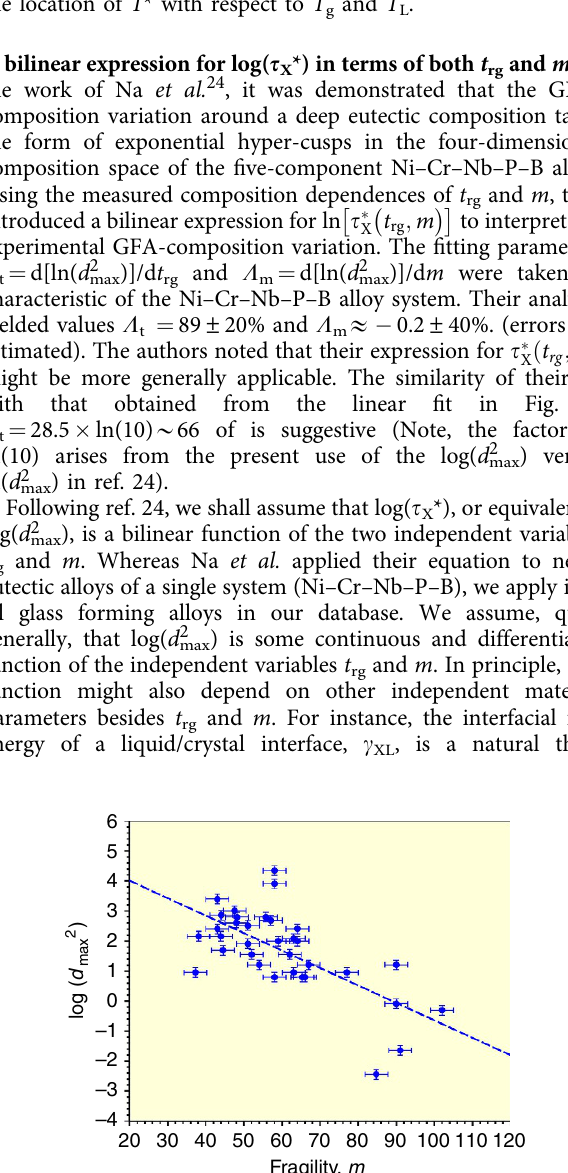
Figure 2 | Plot of log( d max 2 ) as a function of Angell’s fragility parameter m . Dashed line is the result of a linear regression least squares fit with an average slope of L m ¼ (cid:2) 0.0572. The coefficient of determination R 2 is 0.458. Error bars are estimated experimental errors in fragility and casting diameter as described in the